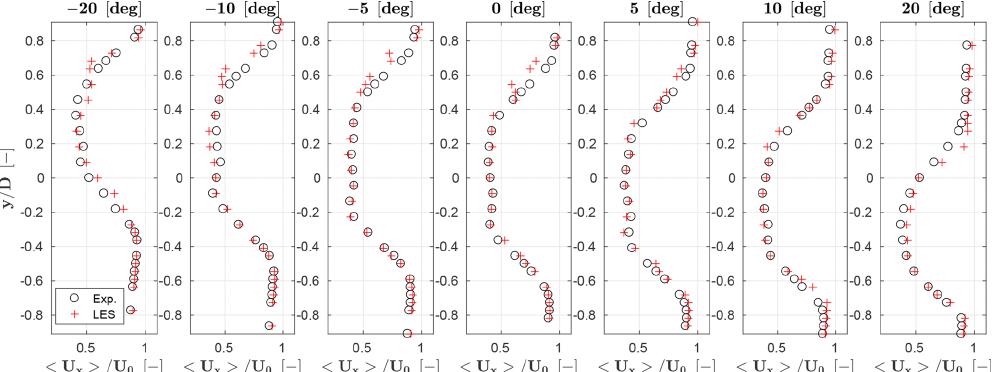
Figure 7. Normalized time-averaged streamwise velocity profiles at hub height for different yaw misalignments 4D downstream of the rotor. Red + symbols: LES; black ◦ symbols: experimental